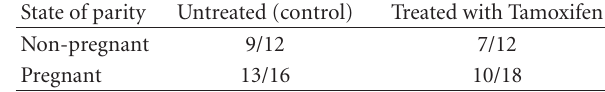
e ffi ciency. Additional work is needed to fully elucidate the role of β 1 integrin in mammary gland development.